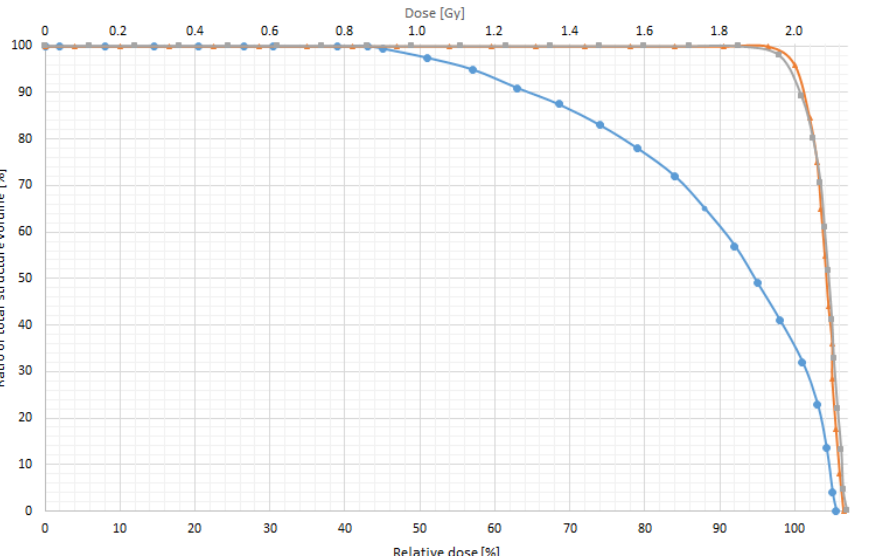
Figure 8. Dose volume histograms for the three single-field plans obtained for the patient-specific phantom: without bolus (blue), with 0.5 cm thick 3D-printed bolus attached to the phantom surface (gray) and 1.0 cm thick 3D-printed bolus attached to the phantom surface